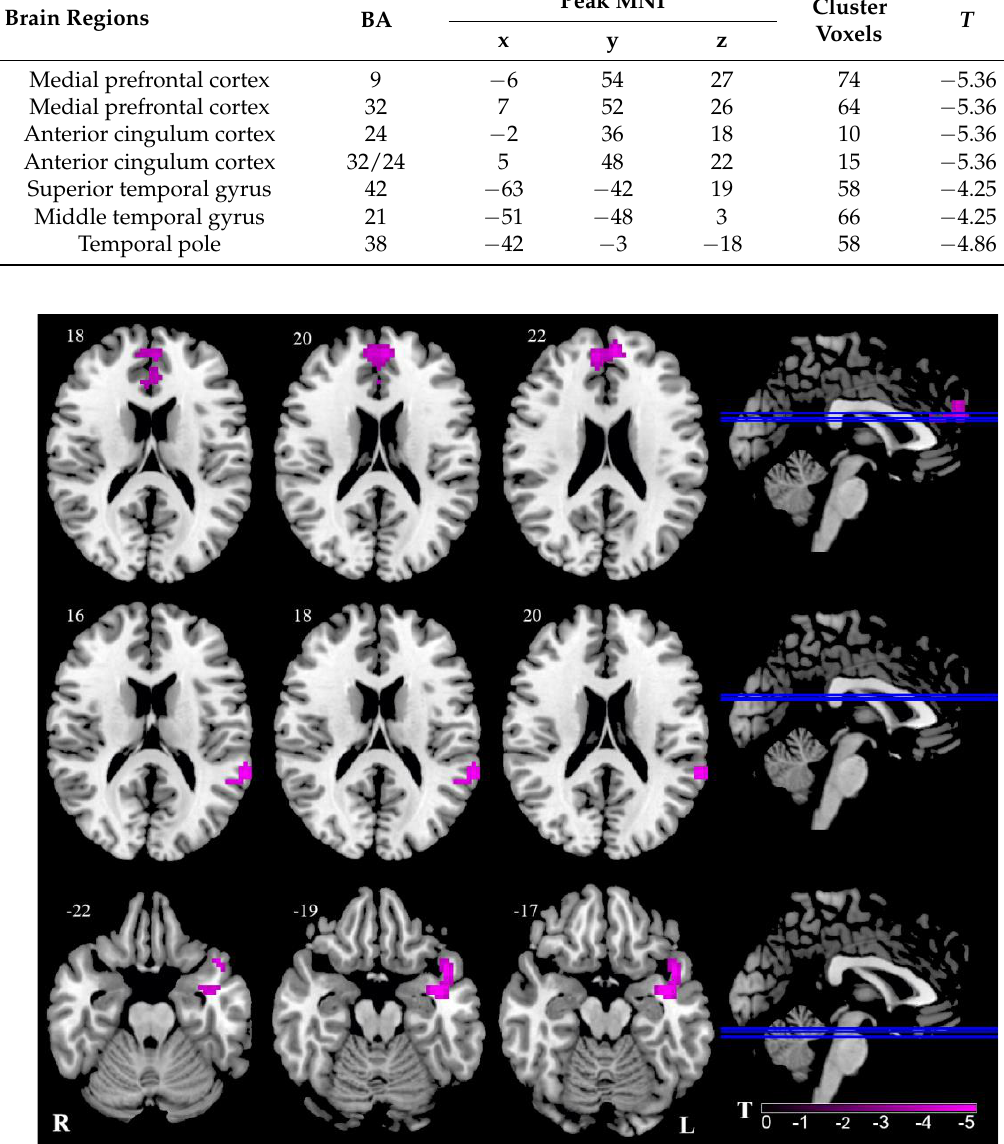
Figure 2. Abnormal FC of VM patients in contrast to HC. Pink signifies decreased ALFF. The axial image was overlaid on the transverse section of the MNI-152 standard anatomical image. Blue line represents the layers in the sagittal. Numbers indicate z slice. The color scale denotes the t-value. R, right; L, left.